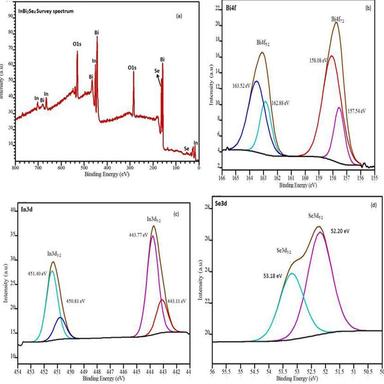
(a–d): The high-resolution XPS spectra of the identified three main elements; (a) survey spectrum; (b) Bi 4f; (c) In 3d; and (d) Se 3d.